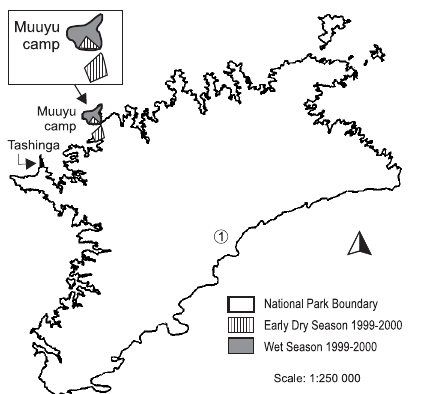
Fig. 5. Map of MNP indicating seasonal ranges of a hand-raised rhino, ‘Mgofu’. 1 = Release